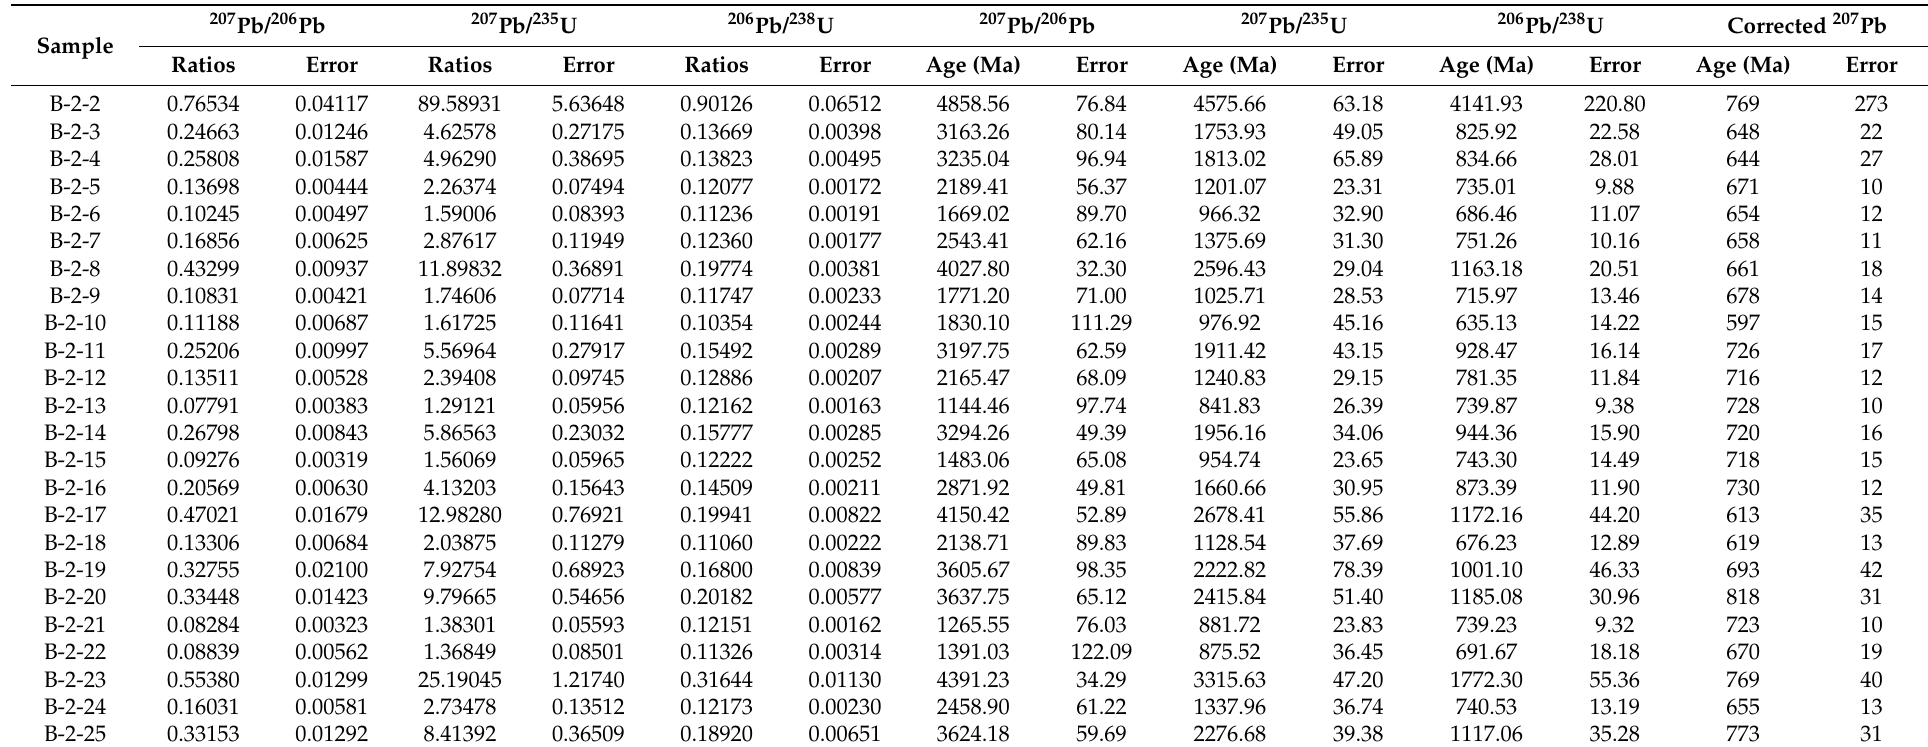
Table 3. Monazite U–Pb isotopic data of the sample B-2 from the Bayan Obo